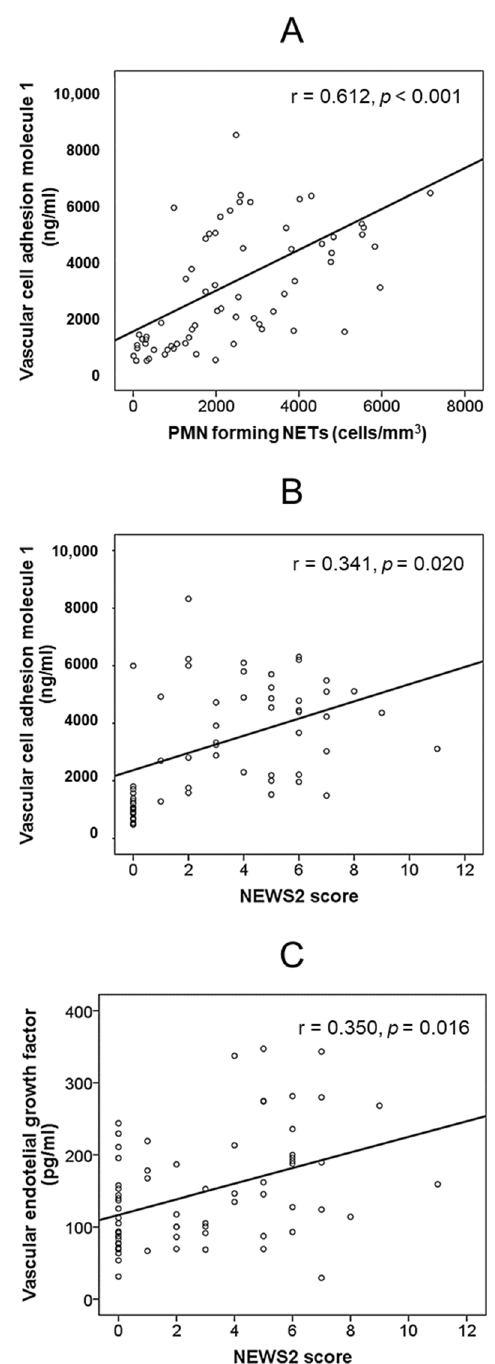
Figure 2. Bivariate correlations between: ( A ) Absolute number of PMNs forming NETs and serum